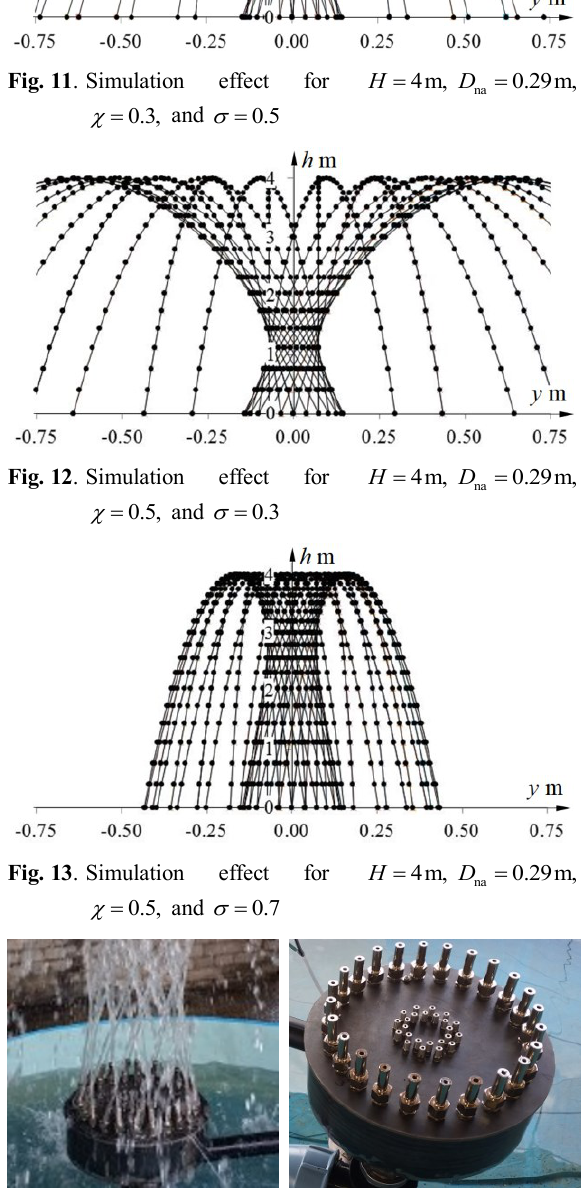
Fig. 14 . (Left) Very initial test results. (Right) Assemble of nozzles – the paper treats the outer